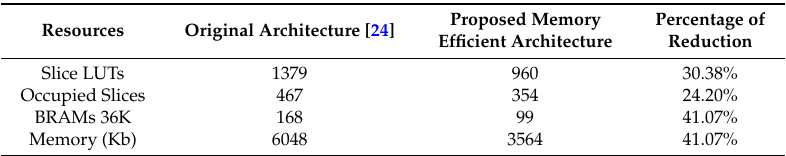
Table 1. Comparison of FPGA Resource Utilization by the Implementations of Proposed Memory Efficient Architecture and Original Algorithm’s Architecture.